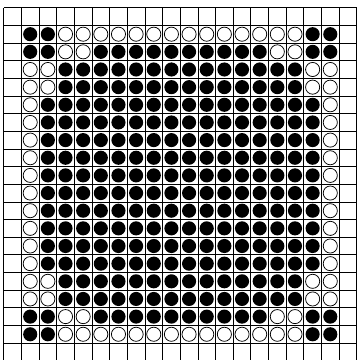
Figure 1. An instance of G 2